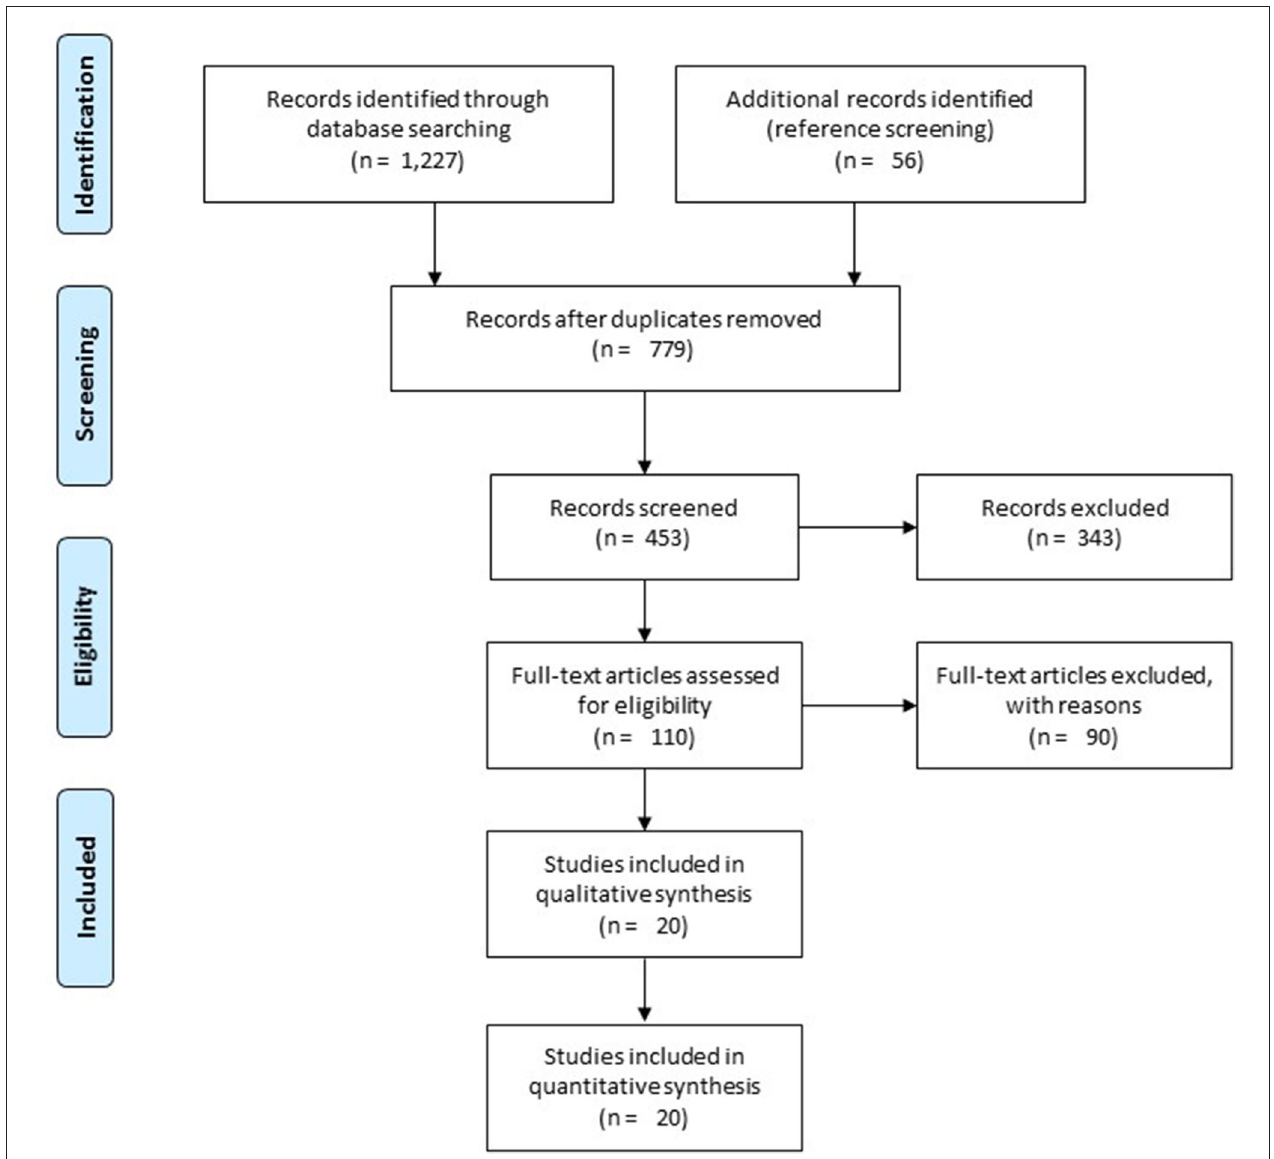
heterogeneity ( I 2 ,